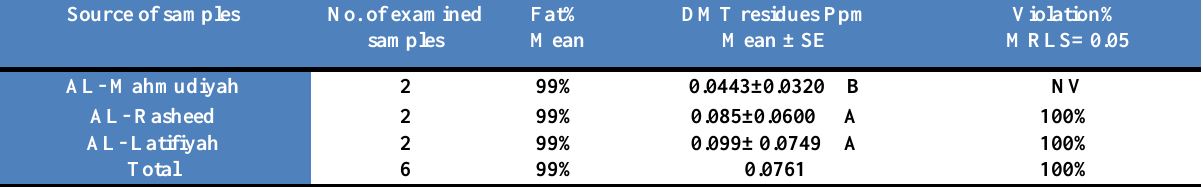
Table, 2: Occurrence of DMT residues and its con hee (Samna) samples collected from different townships during the summer season.